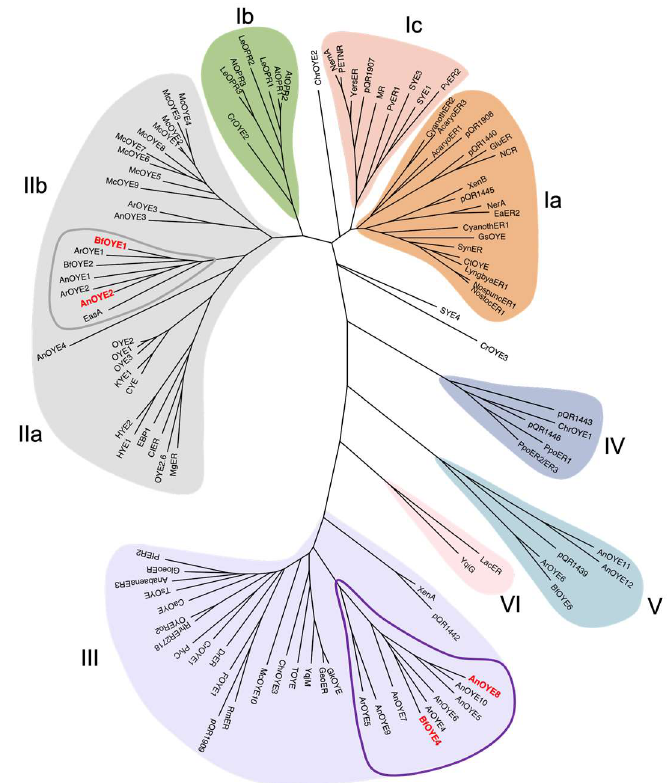
Figure 1. Phylogenetic analysis of fungal and previously described Old Yellow Enzymes. The evolutionary history conducted in MEGA11 was inferred by using the maximum likelihood method based on the JTT matrix-based model. The unrooted tree with the highest log likelihood (−68,148.01) is shown. Accession codes of all sequences used are reported in Table S2.